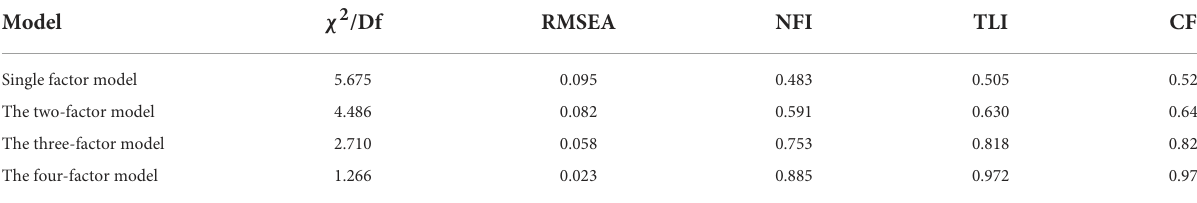
TABLE 2 Cross-layer confirmatory factor analysis.